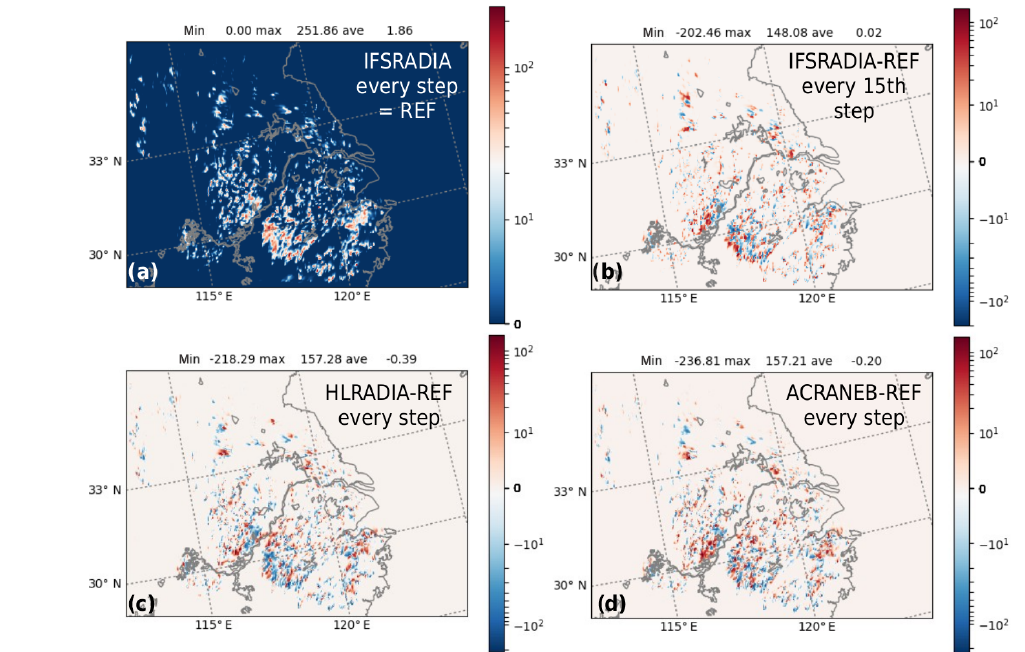
Figure 10. As Fig. 9 but for accumulated rain